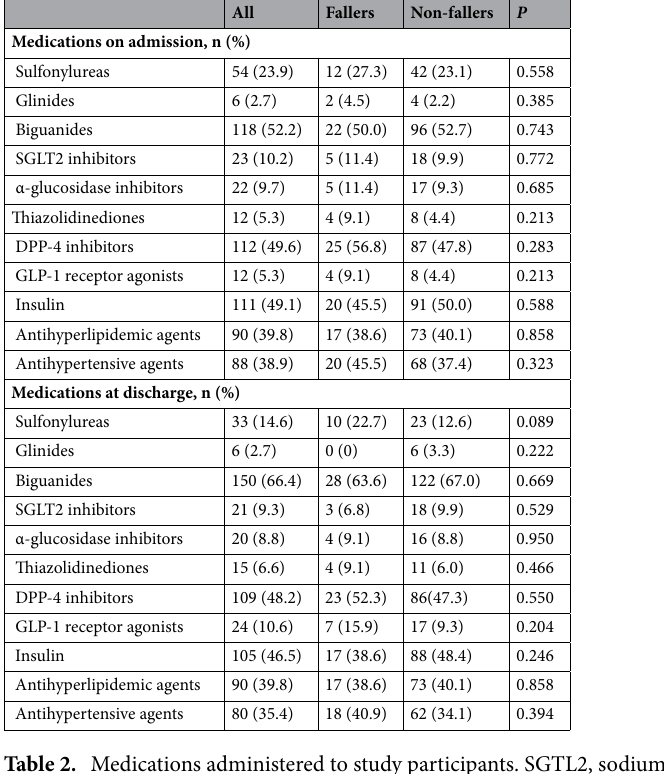
Table 2. Medications administered to study participants. SGTL2, sodium-glucose co-transporter 2; DPP-4, dipeptidyl peptidase-4; GLP-1, glucagon-like peptide-1.